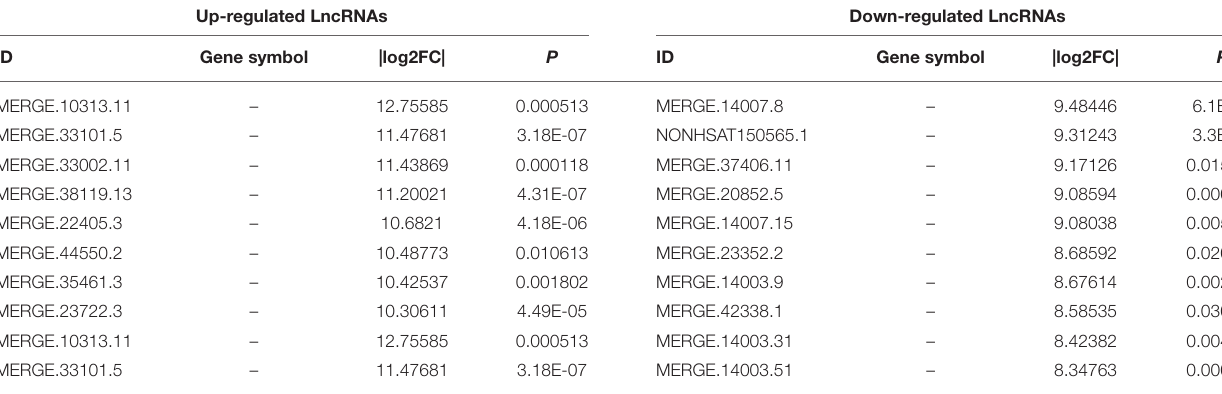
TABLE 2 | Top 10 of differently expressed lncRNAs in HT and non-HT group.